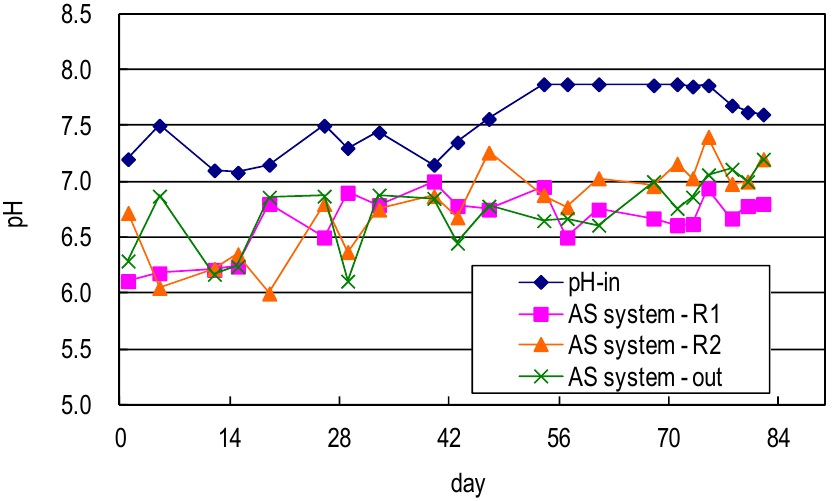
Figure 3. pH value of synthetic domestic sewage treated using AS system.